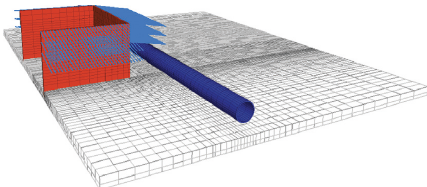
Figure 8: Meshing of the support structure and tunnel. Table 5: Main parameters of each